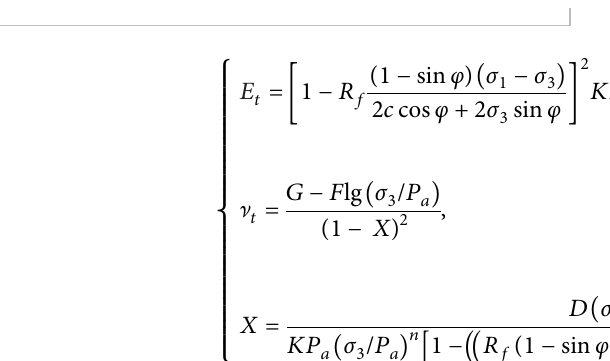
− lg ( σ v − lg ( σ i 3 / P a ), (c) 3 / P a ), and (d) (